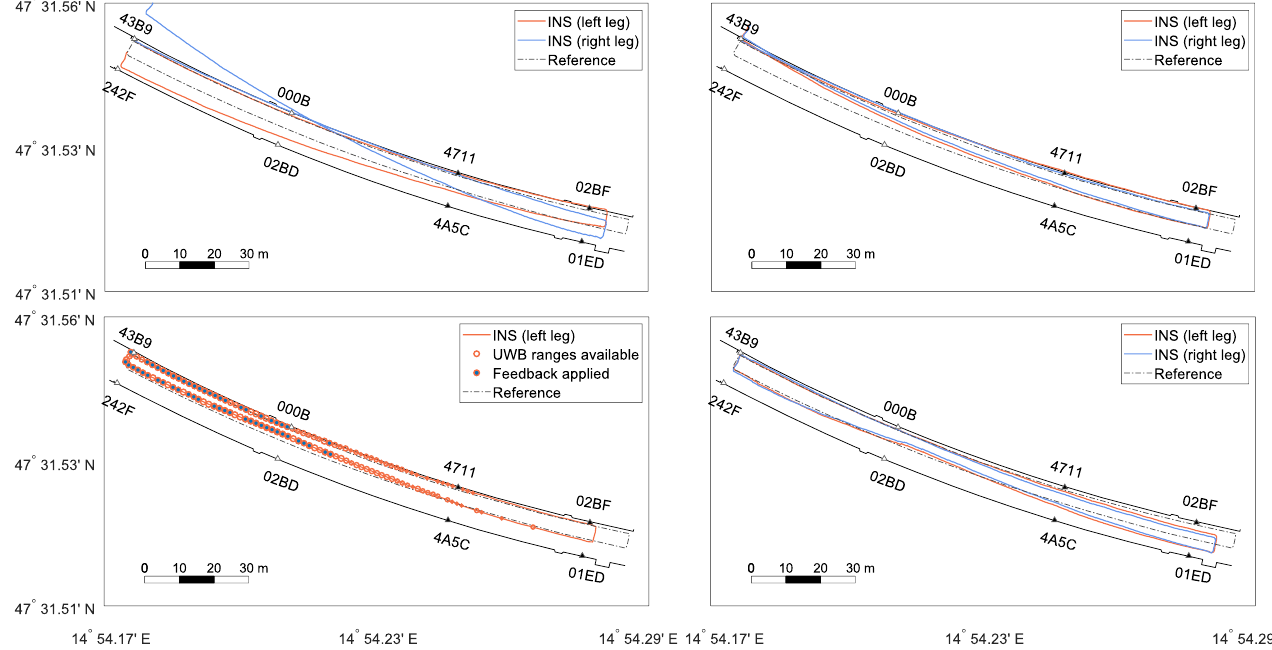
Figure 13. Different filter effects on the INS using the first round of Test 5 as an example. The top left and top right panels illustrate the individual and the fused solution of the foot-mounted zero- velocity-aided INS, respectively. The bottom left panel represents the accumulated position changes from the INS, which act as the input to the particle filter (PF). The bottom right panel shows the corrected INS positions due to the feedback from the PF. The UWB anchors are marked as triangles (white filling: on, black filling: